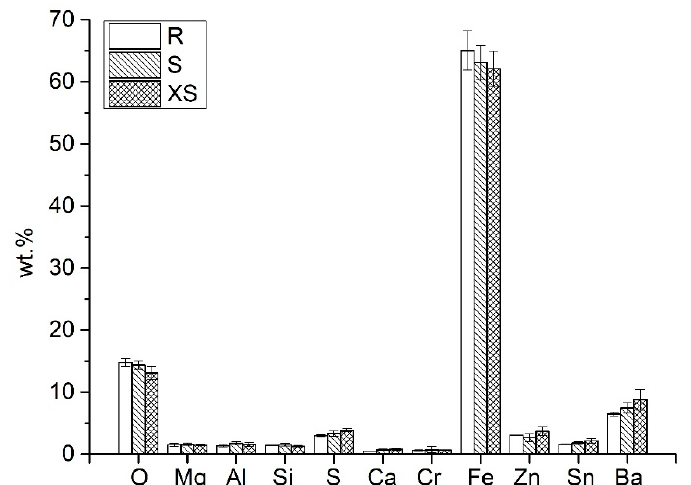
Figure 9. Diagram of the element composition of the secondary plateaus for all the samples: rectified (R), scorched (S) and extra-scorched (XS). Carbon is not quantified.